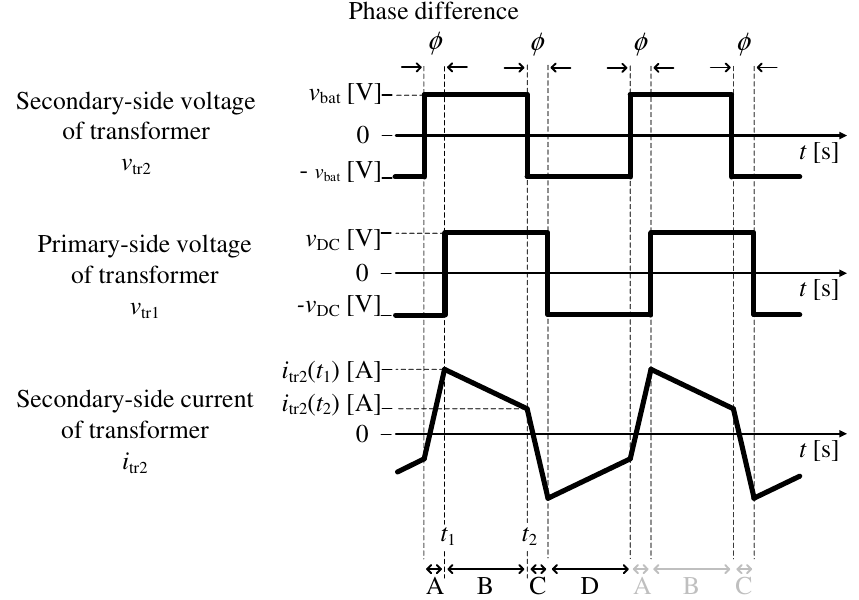
Figure 6. Waveforms of transformer voltage and current when v DC is larger than Nv bat